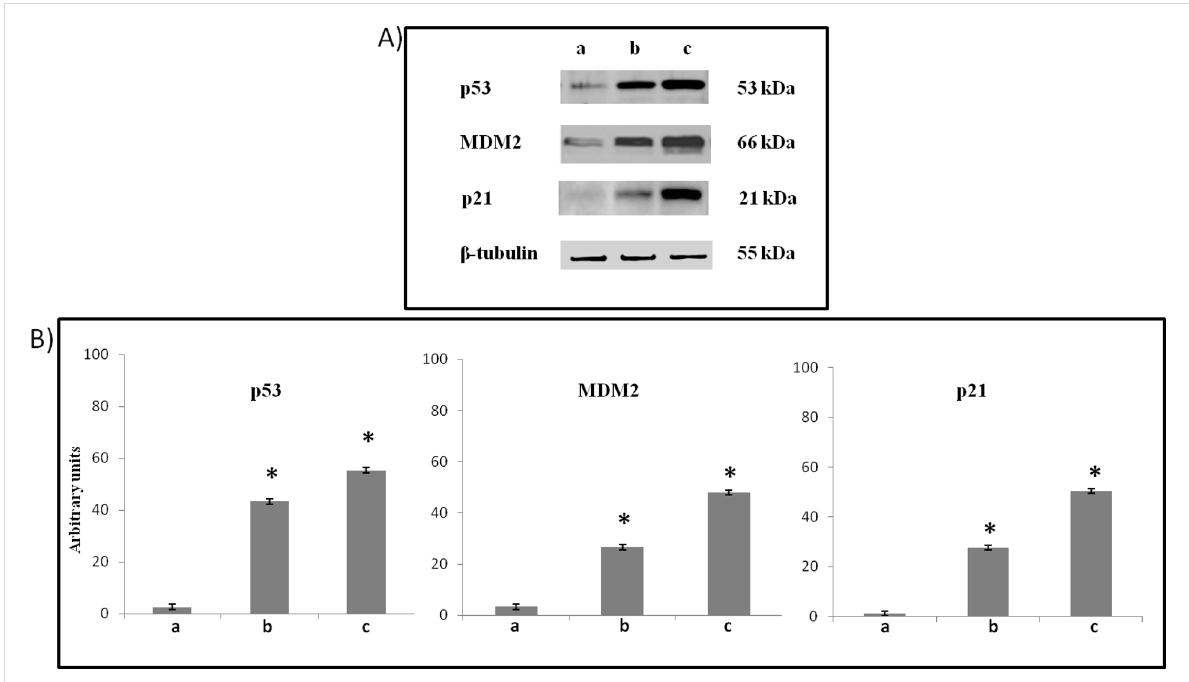
Figure 10: (A) Representative Western Blots and (B) semiquantitative analyses of p53, MDM2, p21 expression levels in total cellular lysates of SH-SY5Y cells non-exposed (a), exposed at 72 h to 10 μ M 6e (b) or 10 μ M Nutlin-3 (c), performed after normalization with β -tubulin. Blots shown are representative ones of a Western Blot analysis of four experiments in duplicate. Results are expressed as the mean ± S.D. of the values of four exper- iments in duplicate. *P < 0.05, significant differences vs controls.